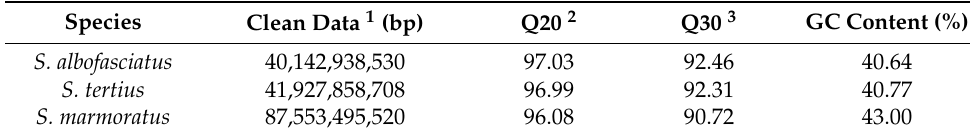
Table 1. Quality control information of sequencing data.